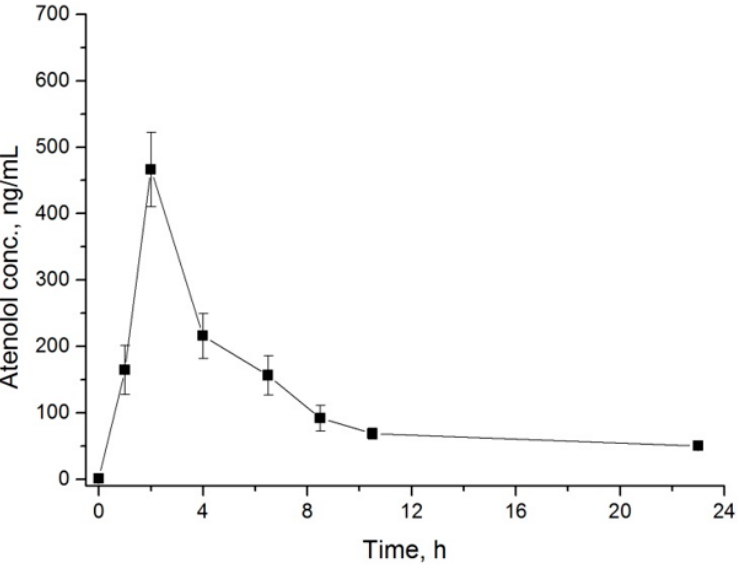
Figure 5. The mean plasma concentration–versus–time plot of atenolol after single oral administration of 50 mg to a healthy human volunteer.